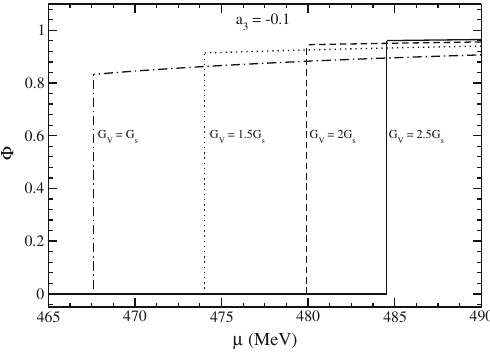
Fig. 10 Φ as a function of the quark chemical potential for a 3 = − 0 . 1 Fig. 11 Φ as a function of μ for G V / G s = 1, 1.5, 2 and